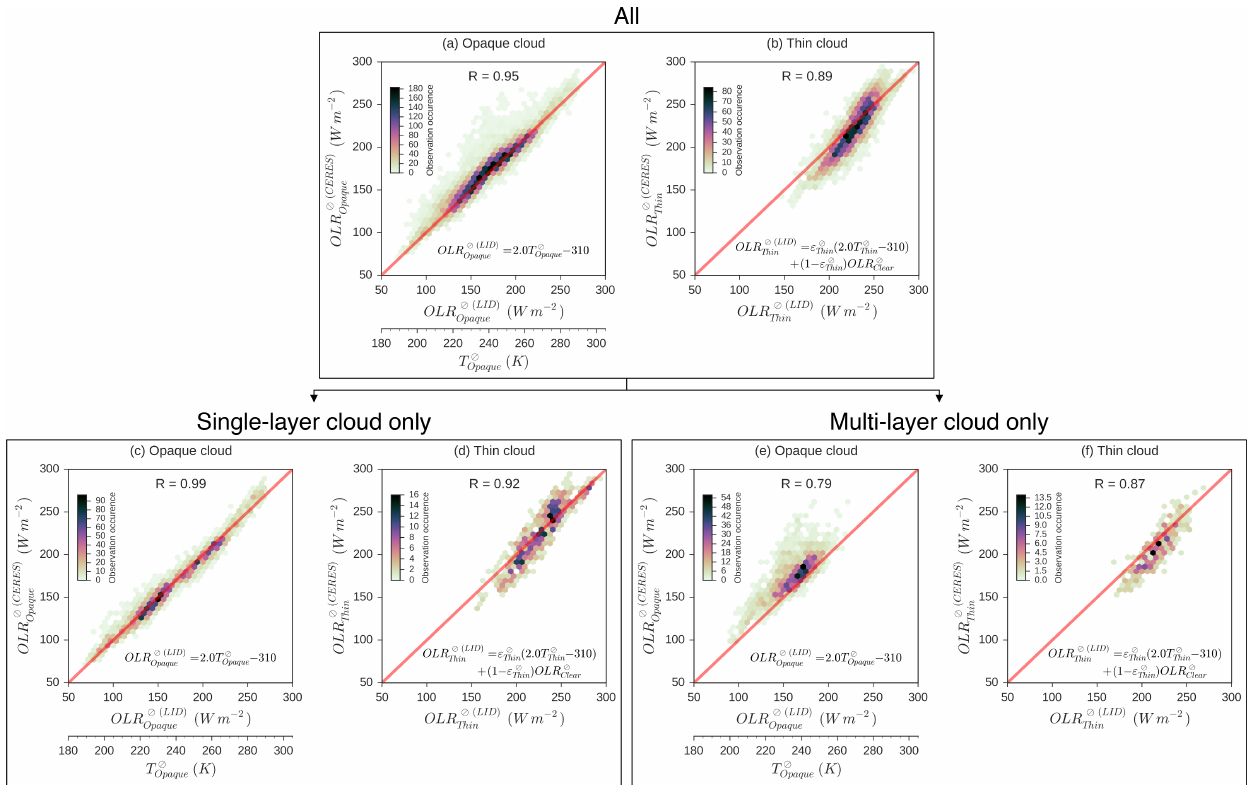
Figure E3. Panels (a, b) are the same as Fig. 6a and b. They are decomposed here into (c, d) single-layer cloud situations and (e, f) multilayer cloud situations.